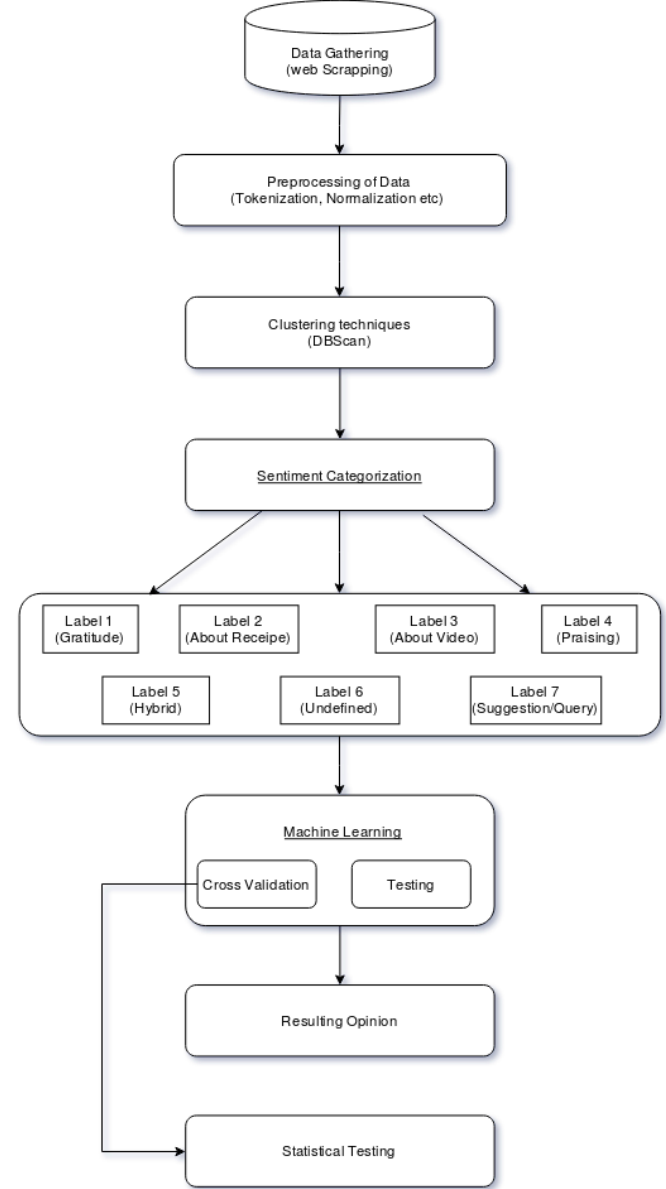
Figure 1. Conceptual diagram showing the